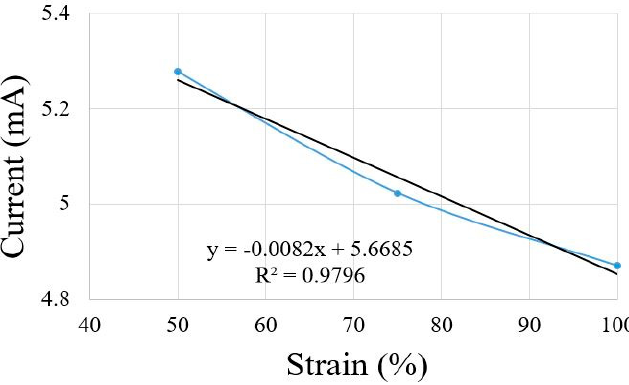
Figure 14. Change in current with respect to different degrees of tensile strain.